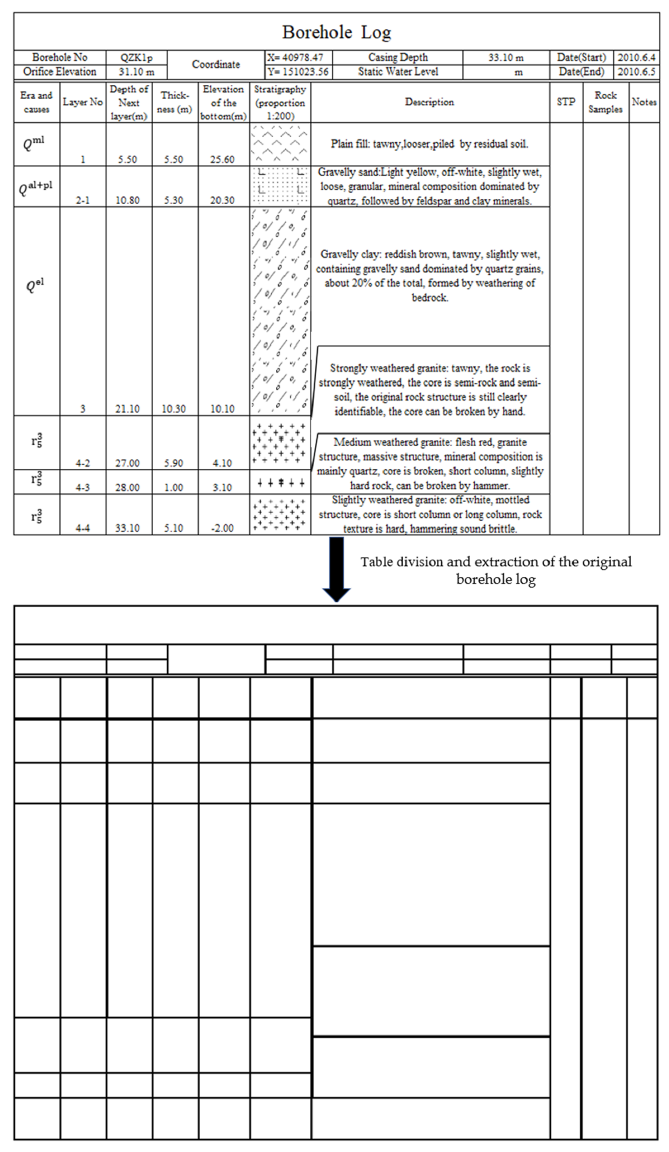
Figure 12. Processing of an original borehole log in Xinyang City.